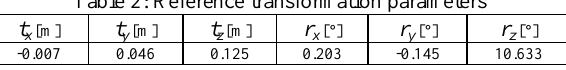
Table 2: Reference transformation parameters